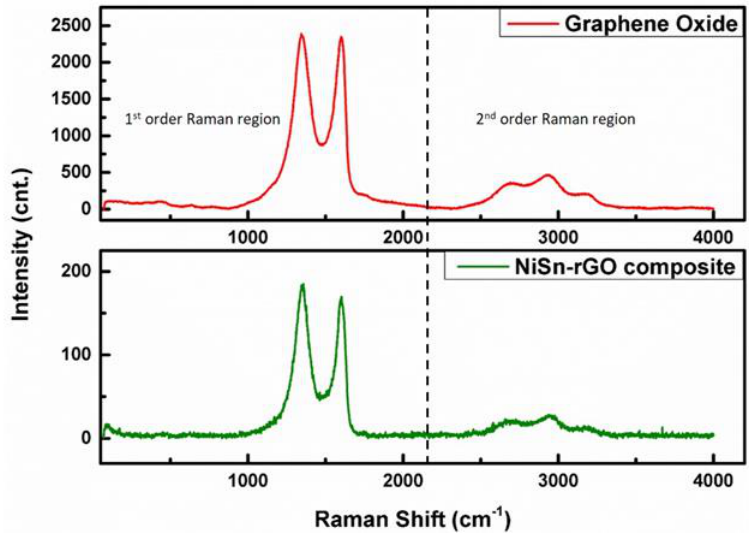
Figure 9. Raman spectra of: ( top ) graphene oxide and ( bottom ) the composite NiSn-rGO-P3.3.